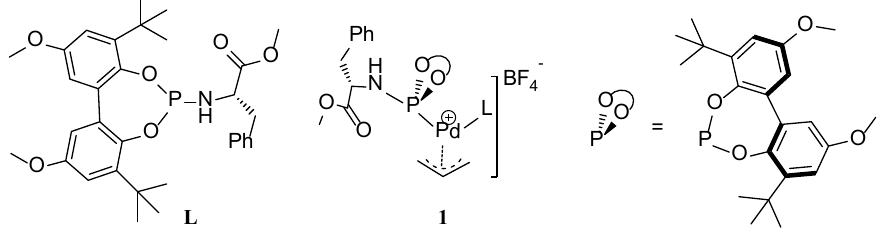
Scheme 1. The structure of phosphoramidite ligand ( L ) and schematic representation of Pd-allyl complex, 1